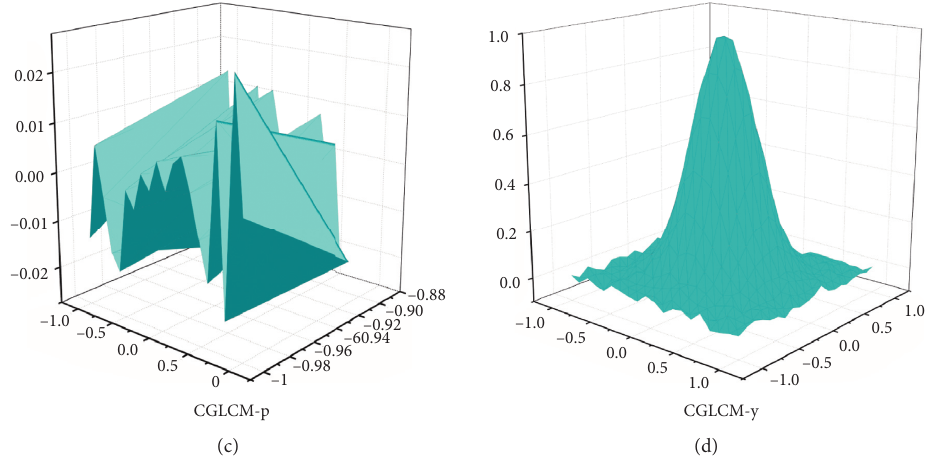
Figure 7: Comparison of the average accuracy and average completeness of the original images.